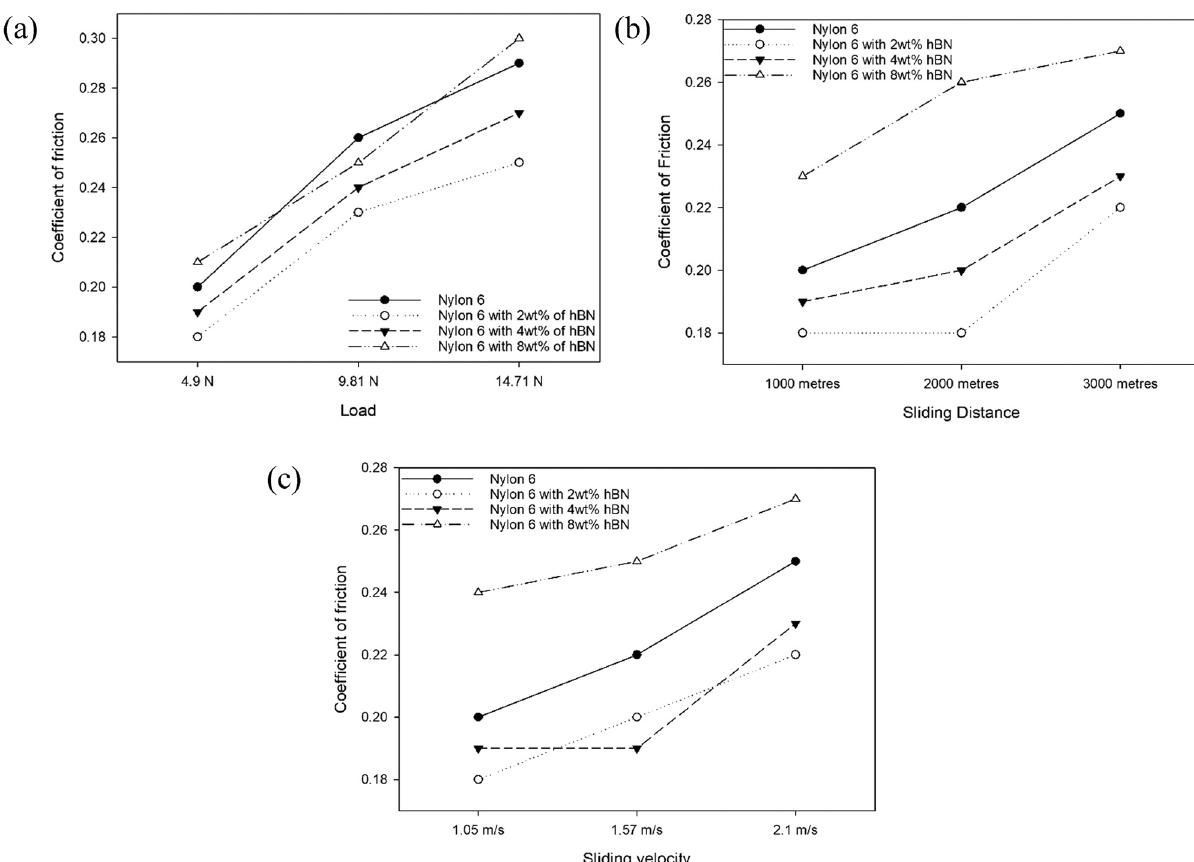
Figure 7: COF vs ( a ) di ff erent loads, ( b ) sliding distances, and ( c ) sliding